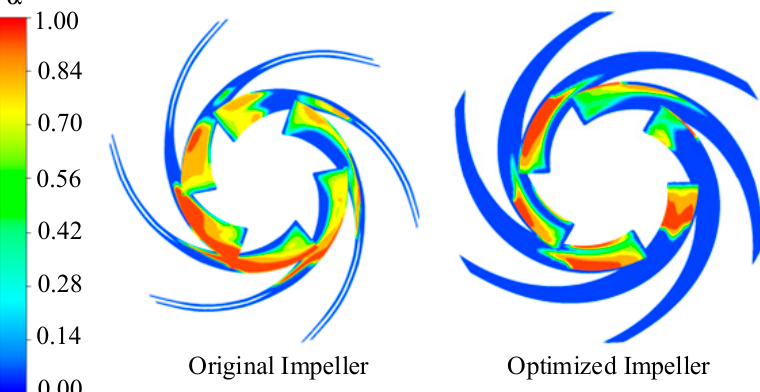
Figure 21. Volume fraction distribution in impeller at NPSH = 8.77 m.